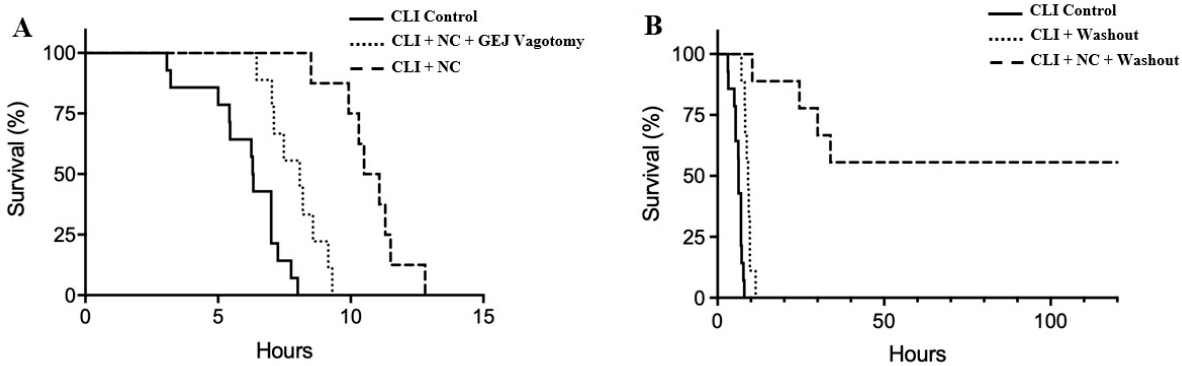
2 h after CLI prolonged survival duration by 3 h to a median of 9.2 (7.8–10.5) h, in com-